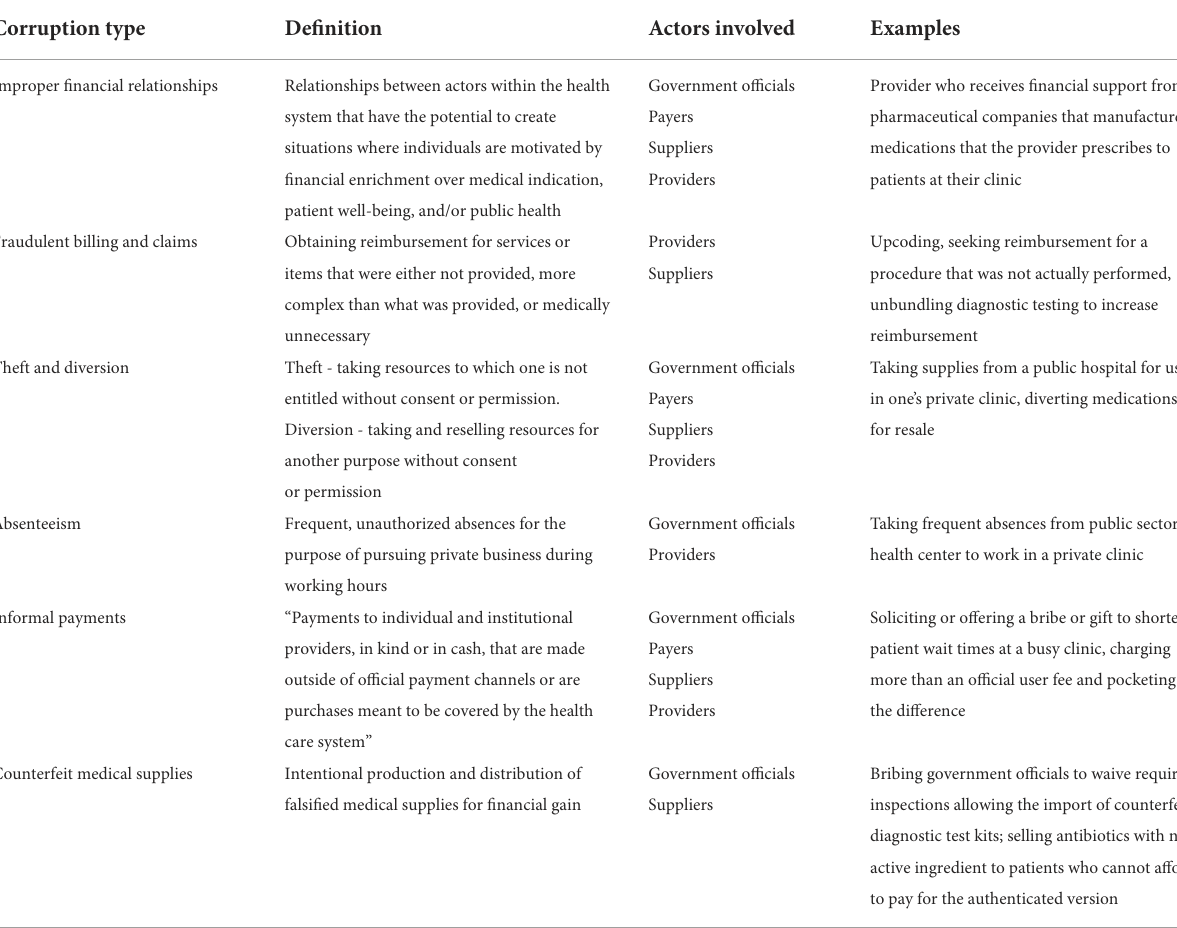
TABLE 1 Forms of health sector corruption and the actors who are